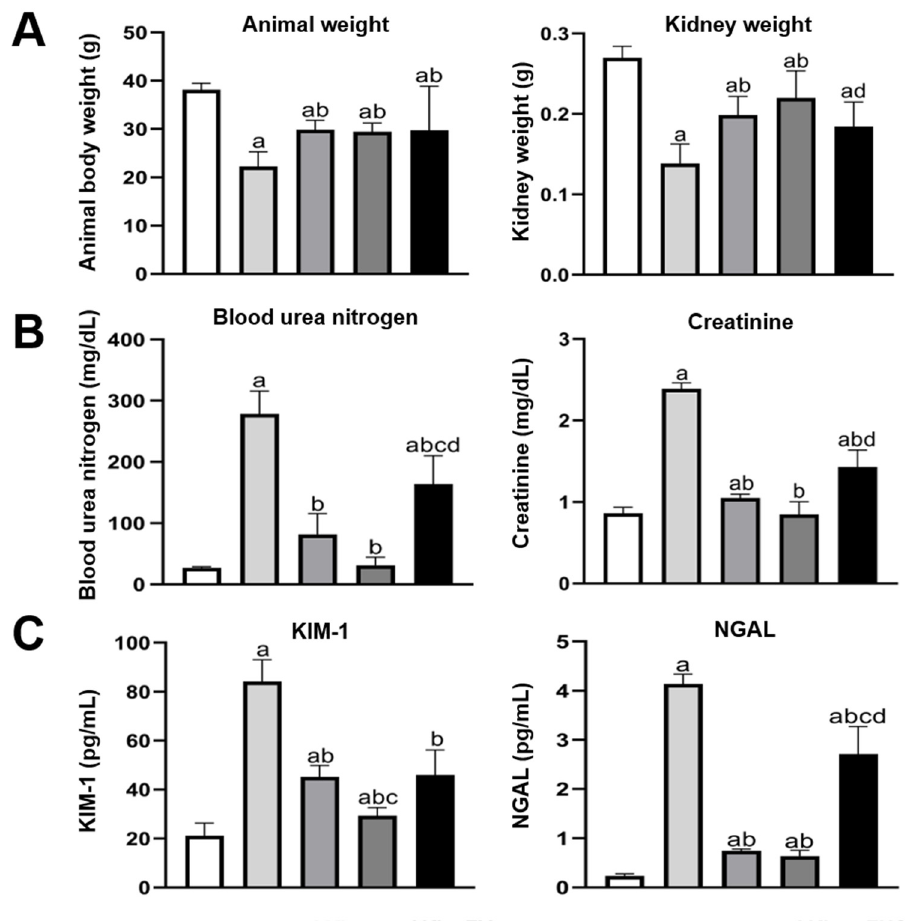
Figure 1. Physiological and biochemical measures of kidney function. ( A ) Animal body weight and kidney weight. ( B ) ELISA of blood urea nitrogen (BUN) and serum creatinine. ( C ) ELISA of molecular kidney injury markers KIM-1 and NGAL. Measurements were taken 9 days following cisplatin treatment. Each group has n = 5 mice. Significant difference a p < 0.05 relative to untreated control; b p < 0.05 relative to AKI; c p < 0.05 relative to AKI + EVs; d p < 0.05 relative to AKI + EVs + pFUS.